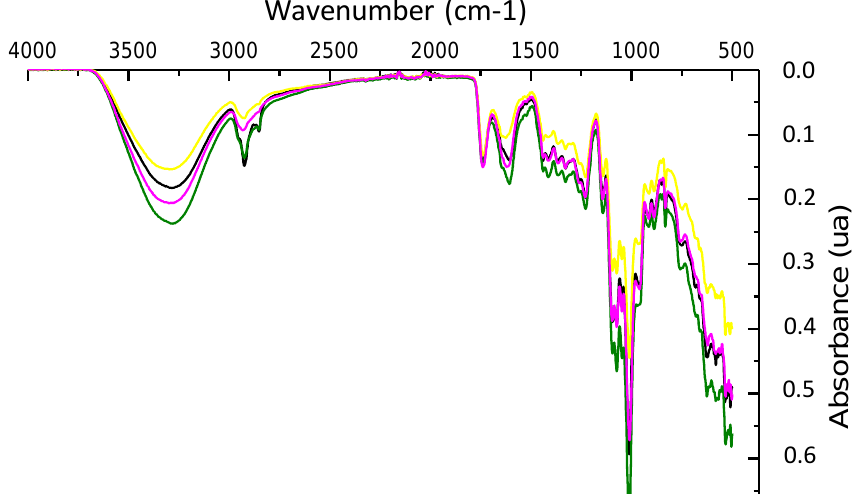
Figure 4. FTIR spectra of PC (------) and PC-5E (------) films and CBSE-2 (------).